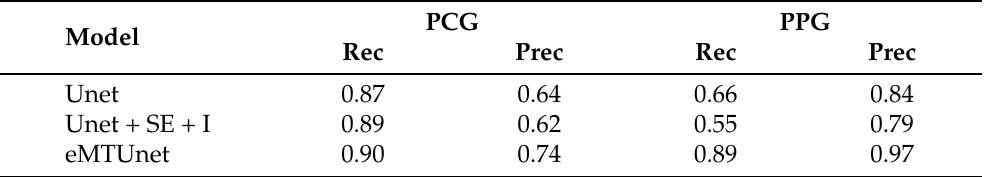
Table 3. Comparison of the segmentation quality, tested on D 6 dataset, between the proposed eMTUnet and the traditional Unet (single input signal and single task), with or without SE and inception (I)